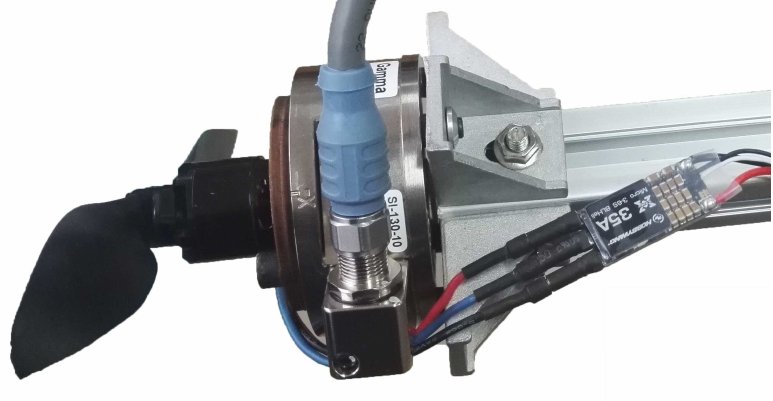
Figure 2. The testing picture of the propeller